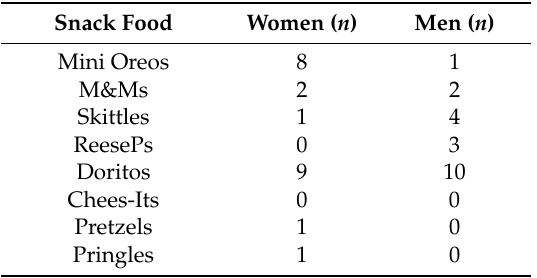
Table 2. Snacks foods chosen for the operant responding